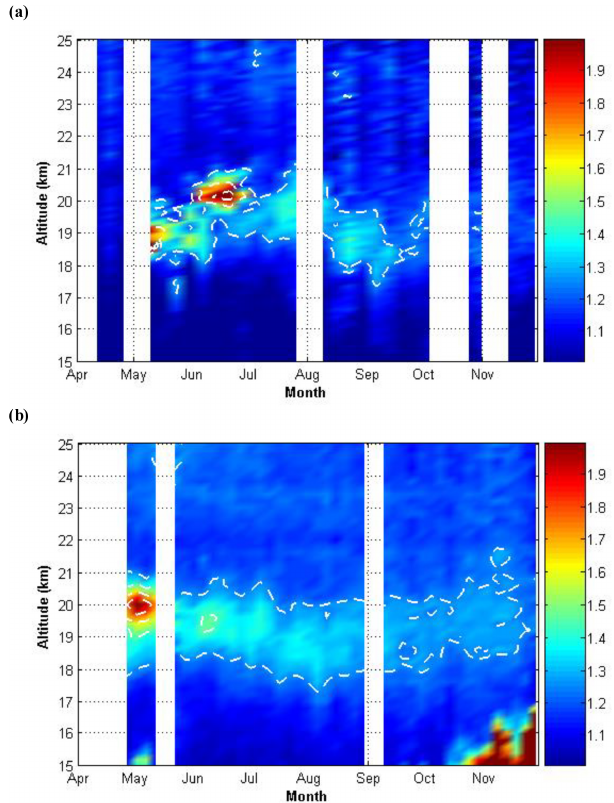
Figure 8. Time series of weekly averaged profiles of scattering ratio at 532nm obtained from ground-based (a) and spaceborne (CALIOP, b ) lidar observations over Reunion Island between April and December 2015. The scattering ratios from CALIOP have been averaged within ± 5 ◦ latitude and ± 50 ◦ longitude (extending from Africa to Australia) around Reunion Island.